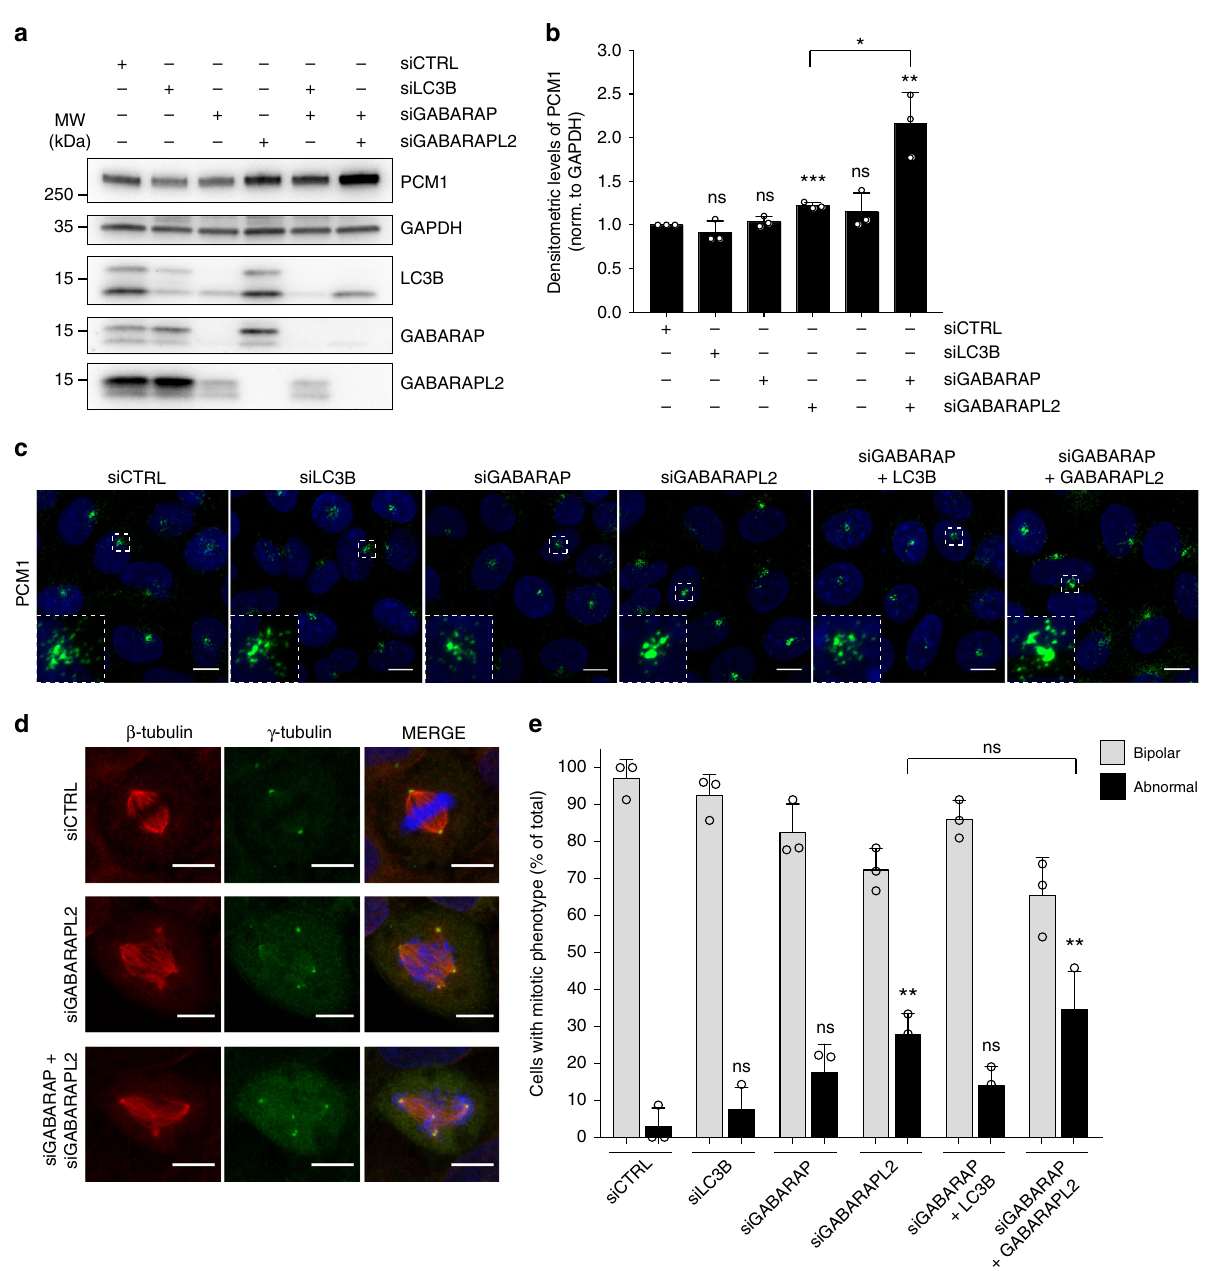
Fig. 8 PCM1 accumulation and mitotic abnormalities show GABARAP selectivity. a Immunoblot of U2OS cell extracts following depletion of LC3B, GABARAP and GABARAPL2 individually or in combination as indicated showing levels of PCM1. GAPDH is used as loading control. b Densitometric quanti fi cation of PCM1 levels relative to GAPDH, represented in ( a ). Columns represent the mean ± SD, n = 3, ns > 0.05, ** P ≤ 0.01, *** P ≤ 0.001. Unpaired Student ’ s t -test, two-tailed. c Representative images of PCM1-stained CS in U2OS cells depleted of the denoted ATG8 proteins. d Representative images of mitotic abnormalities in U2OS cells stained for γ -tubulin, β -tubulin and Hoechst33342 following depletion of the denoted ATG8 proteins. e Quanti fi cation of phenotype distribution in ( d ). Columns represent the mean ± SD, n = 3 of ≥ 20 cells, ns P > 0.05, ** P ≤ 0.01. Unpaired Student ’ s t -test, two-tailed. Abnormal refers to cells exhibiting multipolar, diffuse bipolar or monopolar mitoses. Scale bars, 10 µ m. Source data are provided as a Source Data fi